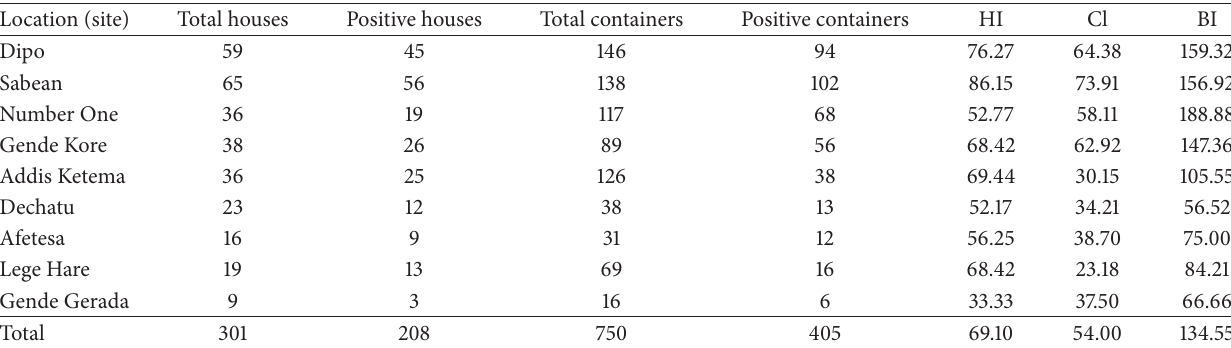
Table 3: Larval indices and distribution of Aedes aegypti breeding habitats at different locations in Dire Dawa. Location